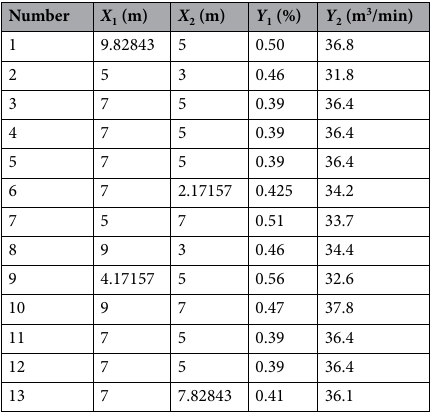
Table 3. Comparison table of central composite design scheme and simulation response values.